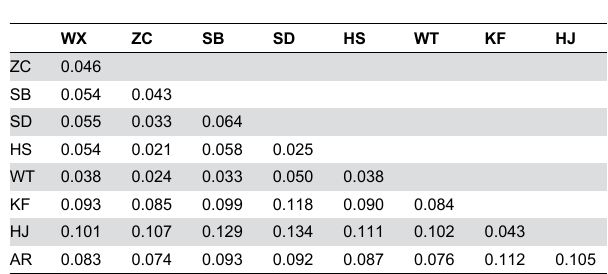
Table 5. Pairwise Nei’s genetic distances between geographical populations of P. eryngii var. tuoliensis .